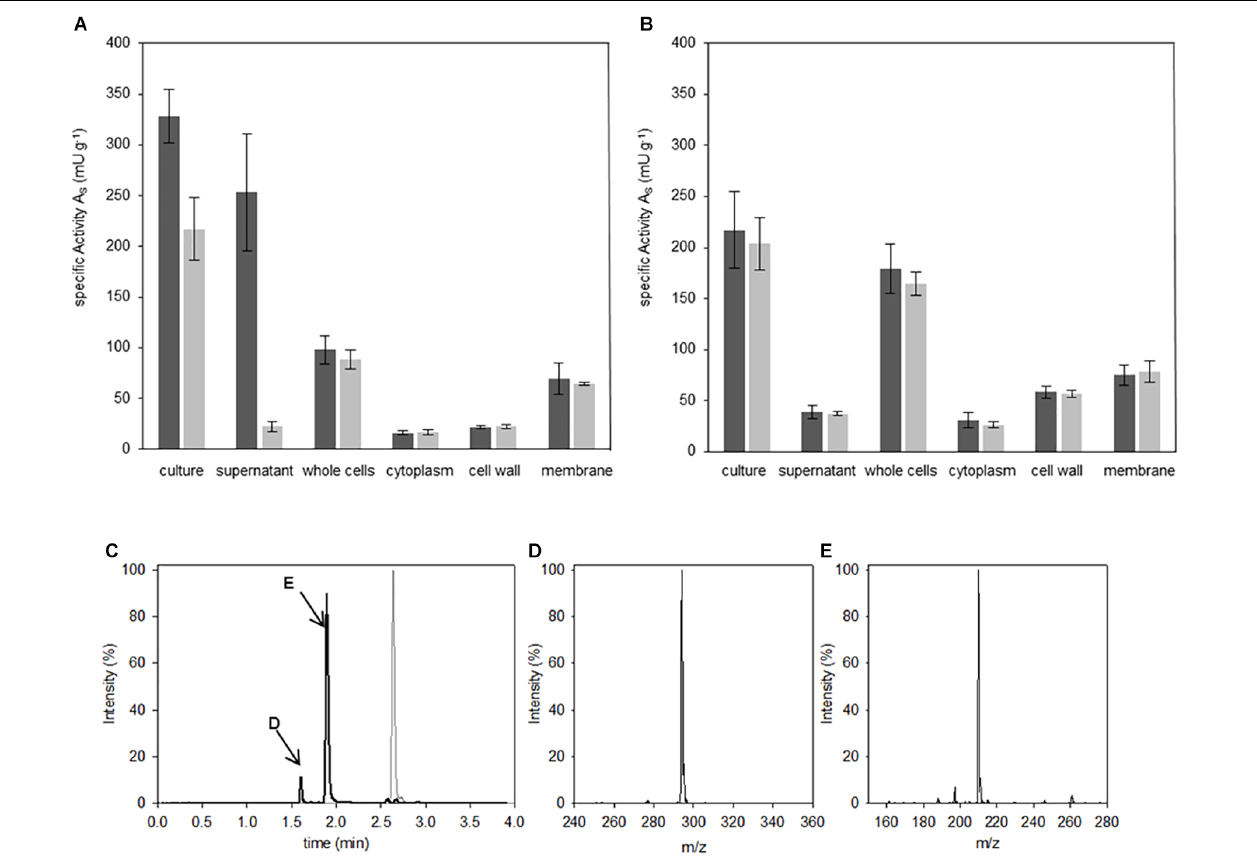
FIGURE 3 | Localization of Abz- D -Arg- D -Ala- p NA activity. Hydrolysis studies were performed in fractions of B. thuringiensis (A) and B. subtilis (B) . 400 µ M IQFS were incubated at 30 ◦ C and changes in fluorescence (dark gray) and UV/ vis -absorption (light gray) were monitored for 8 h (wavelength fluorescence: λ ex = 320 nm/ λ em = 420 nm, wavelength UV/ vis -spectroscopy: λ = 405 nm). Chromatographic reaction analysis of the supernatant fraction of B. thuringiensis analyzed via HPLC (C) (gradient elution: 0–40% ACN, λ = 320 nm). In comparison to the intact starting IQFS (gray), the formation of two product peaks were detected (black line, peaks are indictated with D and E respectivly). The corresponding products were identified via mass spectrometry as Abz- D -Arg-OH (D) [m/z found = 294.3 (M + H + ); m/z calc . = 293.3] and NH 2 - D -Ala-pNA (E) [m/z found = 210.2 (M + H + ); m/z calc . =